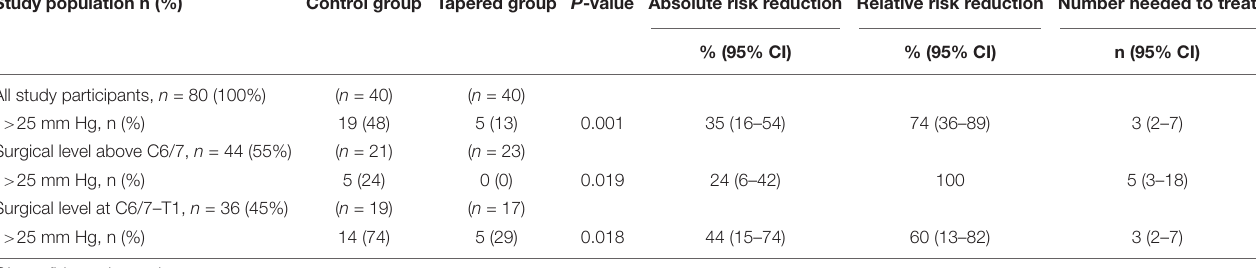
TABLE 3 | The incidence of pressure adjustment when the cuff pressure increased to > 25 mmHg after surgical retraction. Study population n (%)